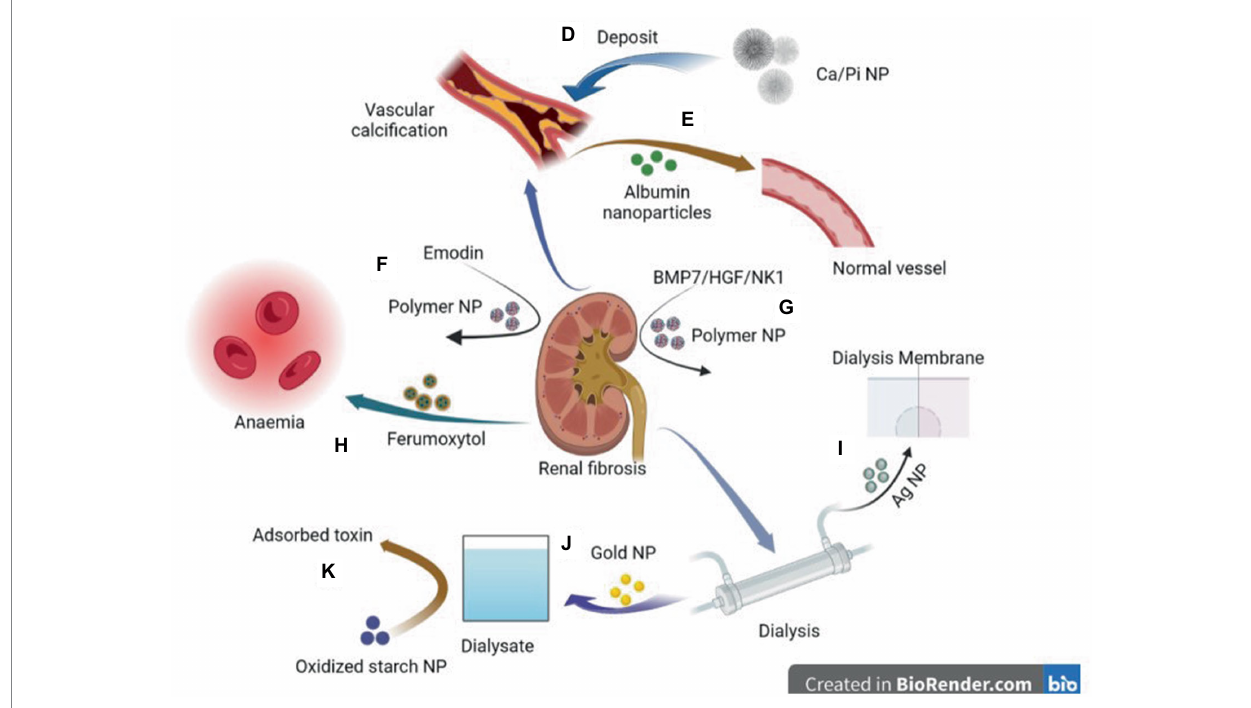
FIGURE 2 Diagram of application of nanoparticles in various comorbidities caused by chronic kidney disease. D: Deposition of CA/ Pi-related nanocrystalline compounds in the vascular wall leads to vascular calcification. E: Elastin antibodies to albumin nanoparticles can reverse CKD—associated MAC. F: Emodin-NP regulates gut microbiome and delays the progression of CKD. G: Plasmid DNA of BMP7 or HGF/NK1 encapsulated in chitosan nanoparticles coated with hyaluronic acid reversed fibrosis progression of the cell and regenerative tubules. H: Ferumoxytol is a novel, semi-synthetic, carb-coated, superparamagnetic iron oxide nanoparticle that can be administered intravenously for iron supplementation. I: Ag nanoparticles modified dialysis membranes to reduce thrombosis. J: A biosensor based on a gold nanoparticle (AuNP) modified Pt electrode can measure relative amino